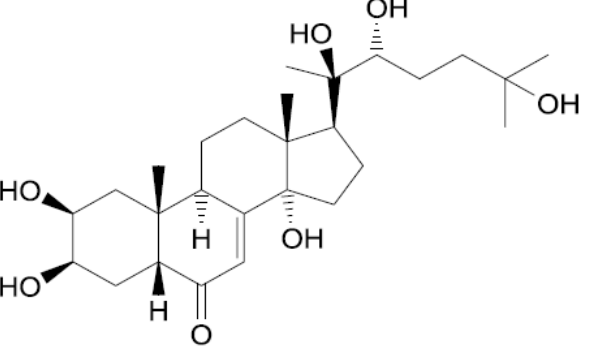
Figure 1. The chemical structure of ecdysterone (20-hydroxyecdysone; C 27 H 44 O 7 ). This group is widely marketed to athletes in dietary supplements as a “natural anabolic agent”, advertised to increase strength and muscle mass during resistance training, reduce fatigue, and ease recovery [2]. Our study of supplements sold on the internet showed